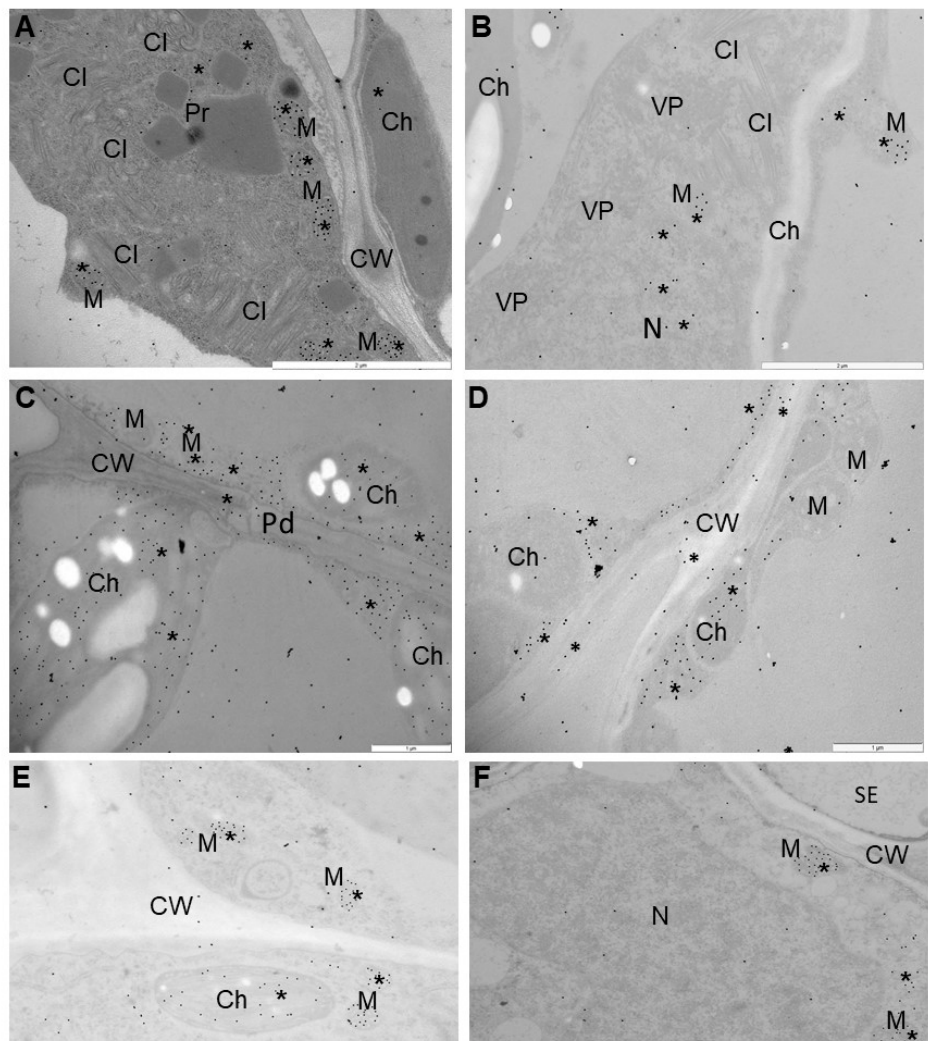
Gold deposition also found in cell wall (CW) and peroxisomes (Pr). Bar = 1 µ m. ( C ) Gold granules (*) indicated glutathione in mitochondria (M), chloroplast (Ch), and nucleus (N) in Neptun potato mesophyll cells. Bar = 1 µ m. ( D ) Glutathione (*) in chloroplast (Ch) and nucleus (N) in Neptun potato phloem parenchyma cells. Gold granules also present in cell wall. Bar 1 = µ m.( E ) Glutathione localization in chloroplast (Ch), mitochondria (M), and cytoplasm in phloem of potato Irys mock inoculated cells. Bar = 2 µ m. ( F ) Glutathione localization in chloroplast (Ch), mitochondria (M), and cytoplasm in the phloem of potato Neptun mock inoculated cells. Bar = 2 µ m.